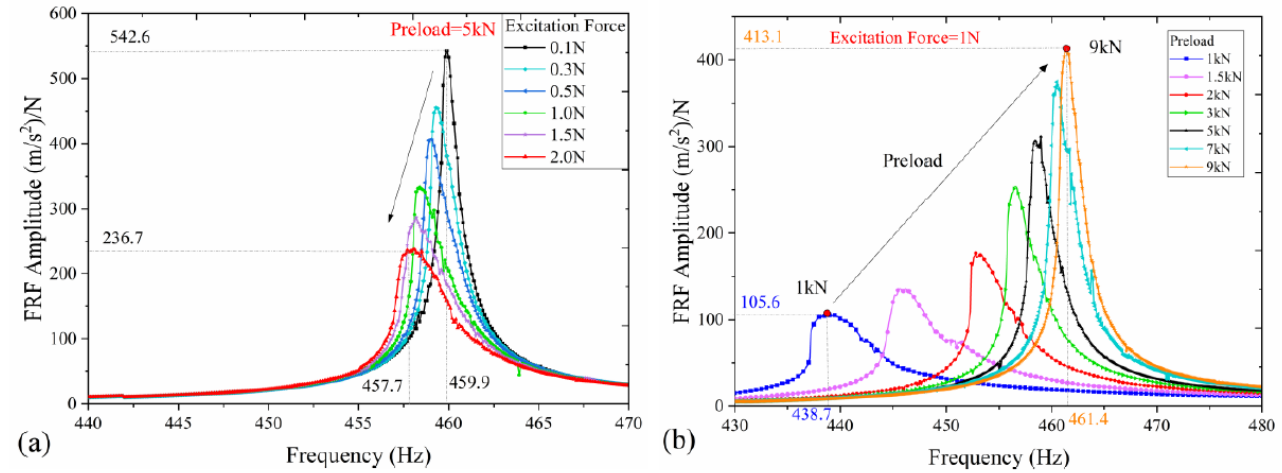
Figure 24. FRFs of bolted joints with small interfaces, influence of ( a ) excitation force, ( b ) bolt tension.